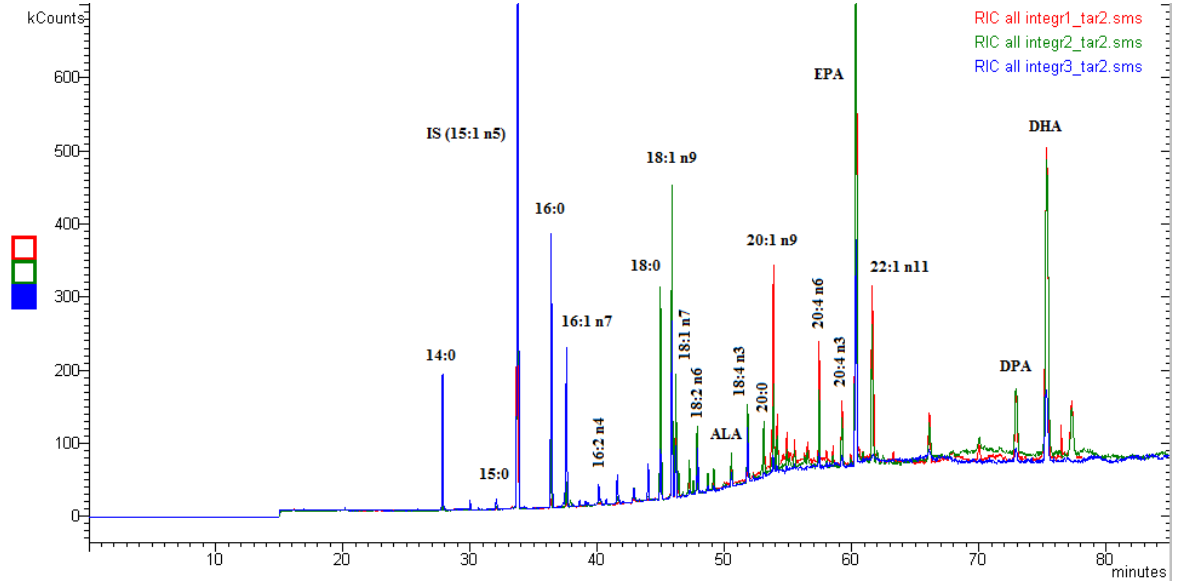
Figure 2. GC-MS chromatograms of the three supplements analyzed. Chromatograms are overlaid.